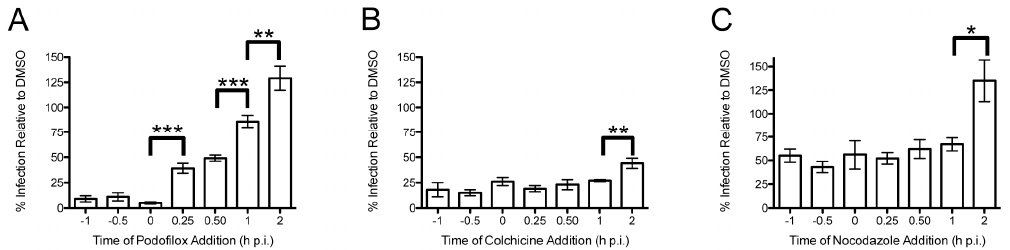
Figure 2. Anti-CMV pharmacokinetics is varied among microtubule inhibitors. MRC5 cells were infected with AD169 IE2-YFP and treated with 50 nM podofilox ( A ); 500 nM colchicine ( B ); and 5 µ M nocodazole ( C ) at various times relative to infection. Infected cells were analyzed for fluorescent intensity at 18 h p.i. to determine the number of virus-infected cells. The percent infection was normalized to cells receiving DMSO pretreatment as 100%. Columns represent mean of six replicates and error bars show standard error. * p < 0.05, ** p < 0.01, *** p < 0.001.